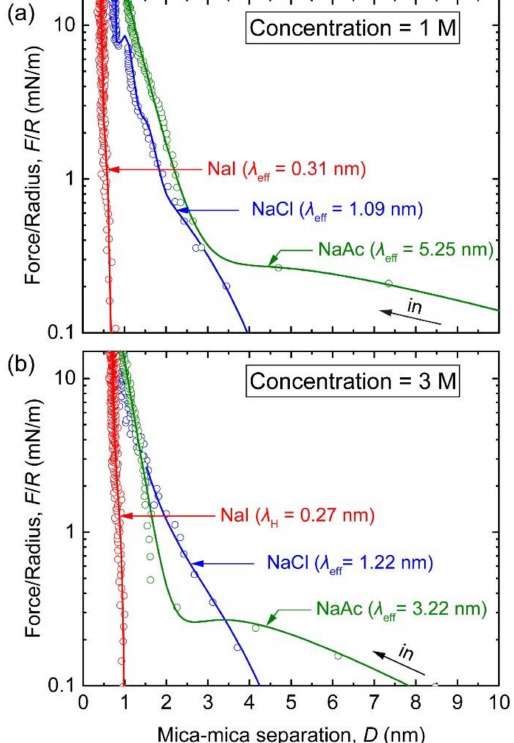
Figure 3. Semi-log plot of F / R versus D ( F / R vs. D profiles) between two mica surfaces in the electrolyte solutions at concentrations of ( a ) 1 M and ( b ) 3 M. The solutes include NaI (red), NaCl (blue), and NaAc (green). The decay length for each solution is noted in the corresponding